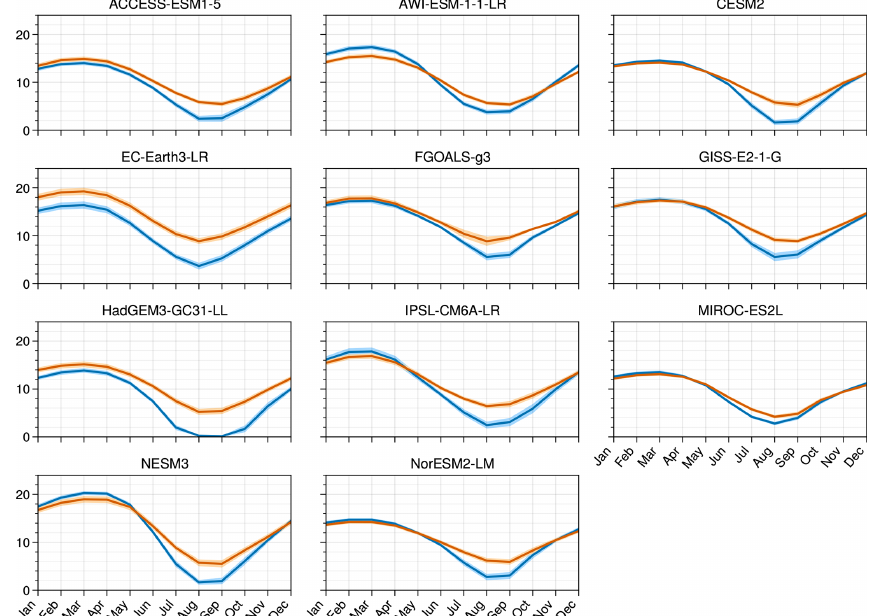
Figure A2. Sea ice area climatological seasonal cycle for each model.